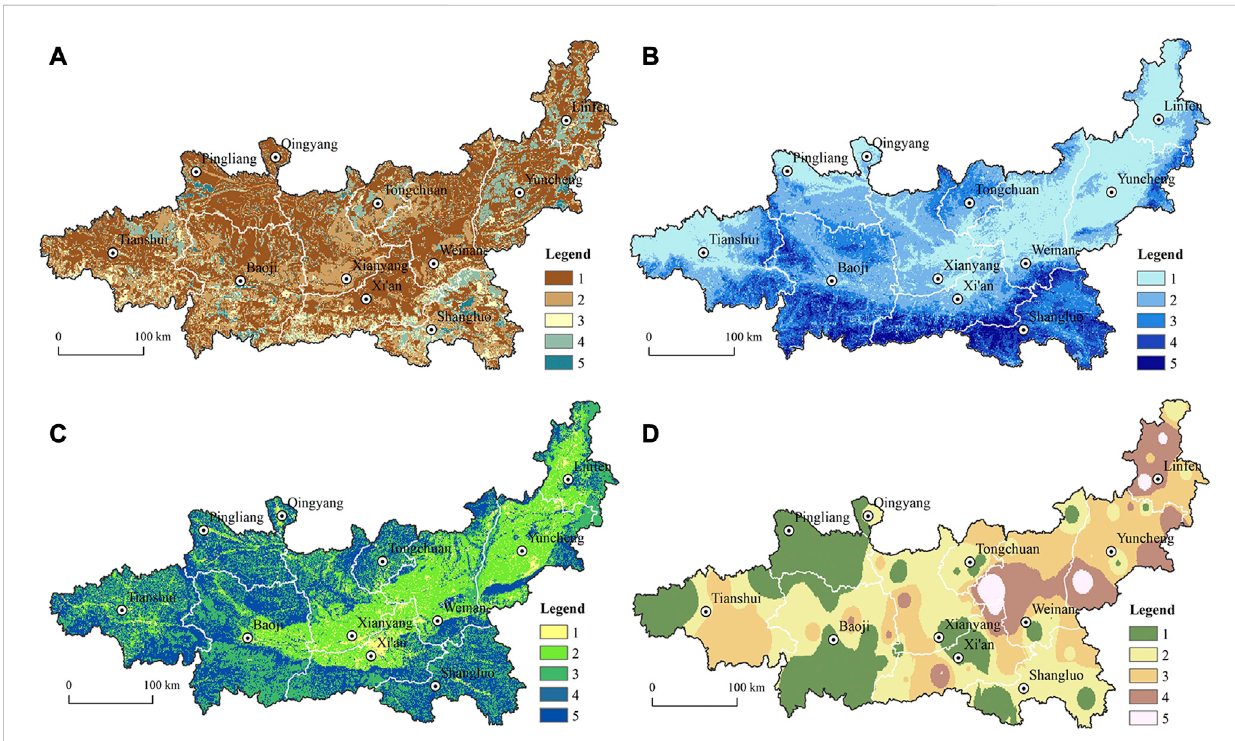
FIGURE 4 Spatial pattern of ecosystem elements in GPUA: (A) soil conservation; (B) water conservation; (C) habitat quality; (D) food supply (Grade 1 = lowest; Grade 5 = highest; 1 to fi ve refer to generally important, more important, moderately important, highly important, and most important.).